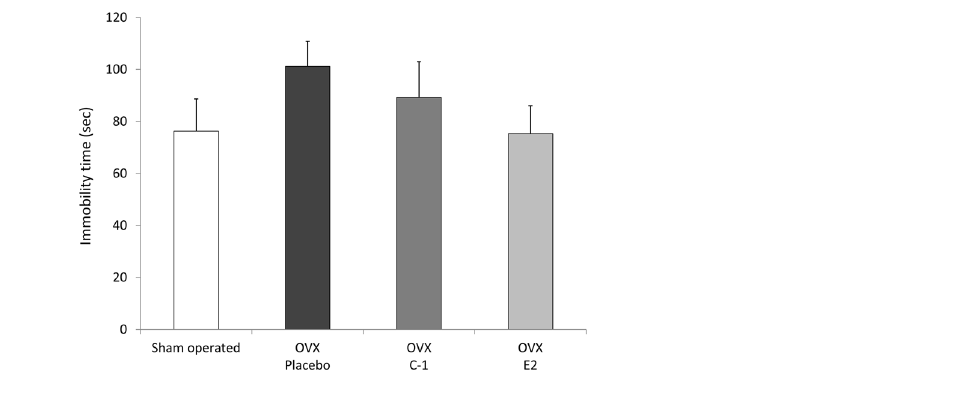
Figure 7. Results of forced swim test during 3–6 minutes in sham-operated mice and ovariectomized mice administered placebo, C-1, or E2. The mean immobility time during 3–6 minutes of the forced swim test is shown. No significant difference was found between groups. Error bars represent standard errors of the